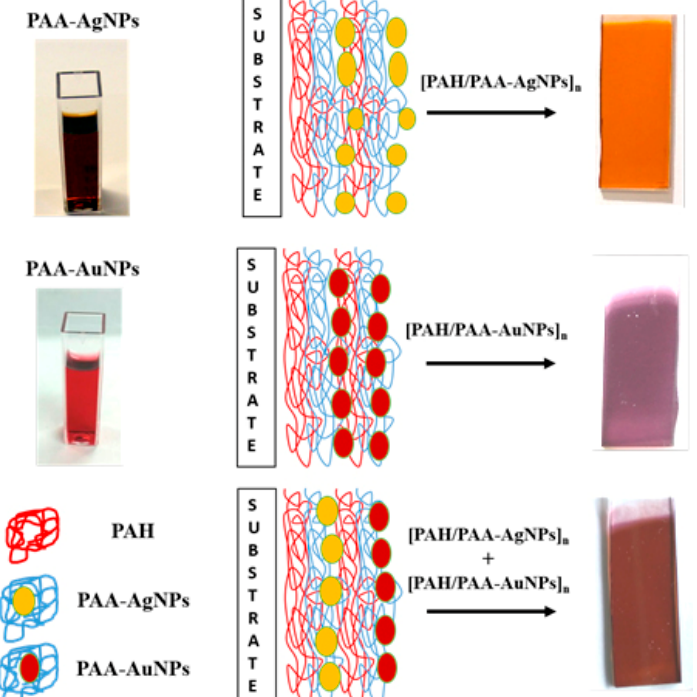
Figure 2. Aspect of the synthesized metallic nanoparticles (PAA-AgNPs, PAA-AuNPs), a schematic summary of the methodology for obtaining the LbL coatings based on the immobilization of metallic nanoparticles and final aspect of the LbL coatings on reference glass slides with a characteristic coloration after deposition process.